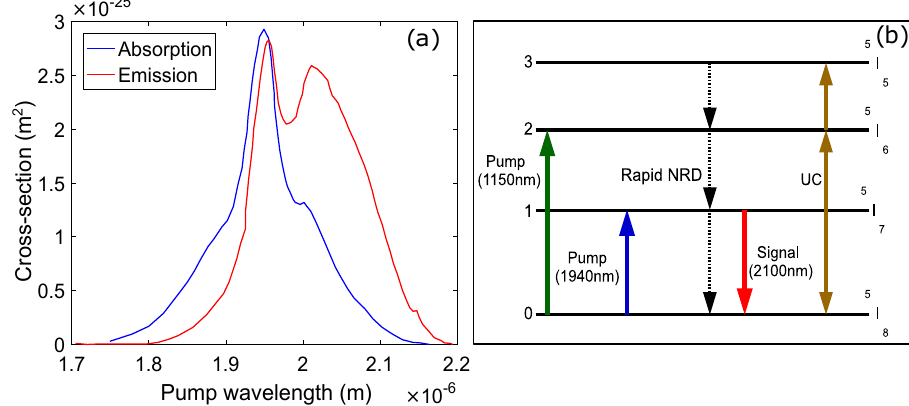
Figure 1. ( a ) Absorption and emission spectra of Ho 3 + ( b ) Energy level diagram of Ho 3 +